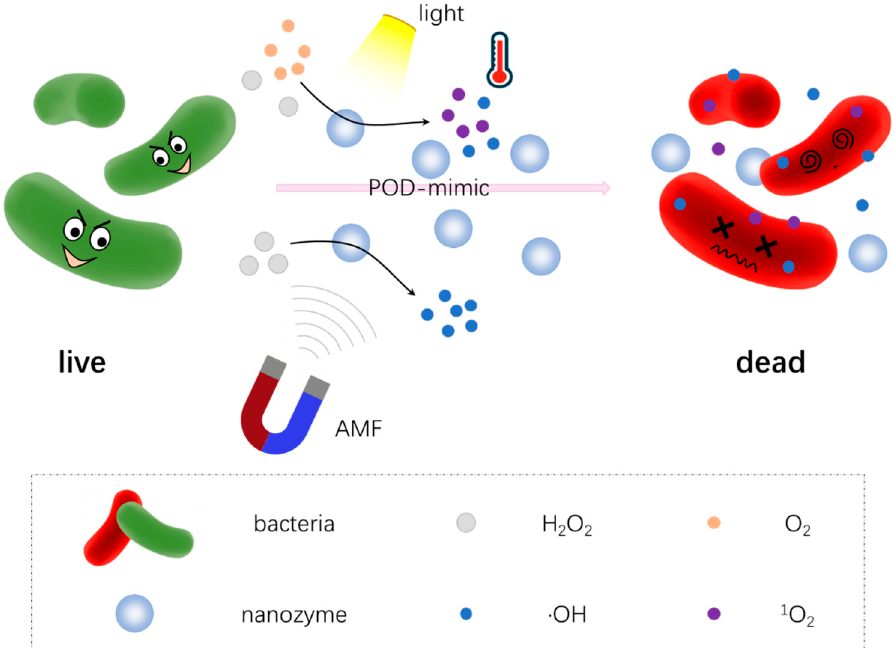
Figure 6. Schematic illustration of the antibacterial mechanism of combination therapy using nanozybiotics. Here, for example, nanozybiotics based on peroxidase (POD)-like nanozymes can catalyze the decomposition of hydrogen peroxide (H 2 O 2 ) to produce bactericidal ·OH. With the radiation of light (visible or near-infrared light), photo-activated therapy (PTT and PDT) is active with excellent hyperthermia, singlet oxygen ( 1 O 2 ) and more ·OH production. The produced ·OH and 1 O 2 interact with bacteria to induce membrane peroxidation and damage cell integrity, making bacteria more vulnerable. In addition, the alternating magnetic field (AMF) exposure also can enhance the catalytic activity of nanozymes and generate more toxic ·OH.